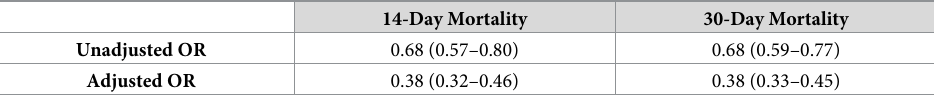
Table 4. Unadjusted and adjusted odds ratios for the 14-day and 30-day mortality aspirin cohorts (95% confi- dence interval). All odds ratio p-values are <